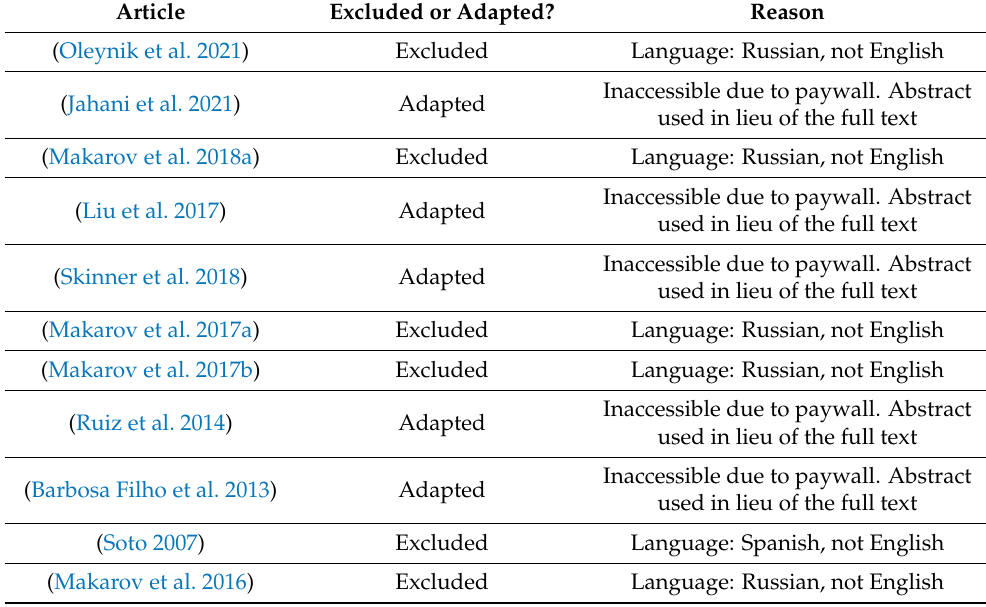
Table 4. Exclusion and adaptation